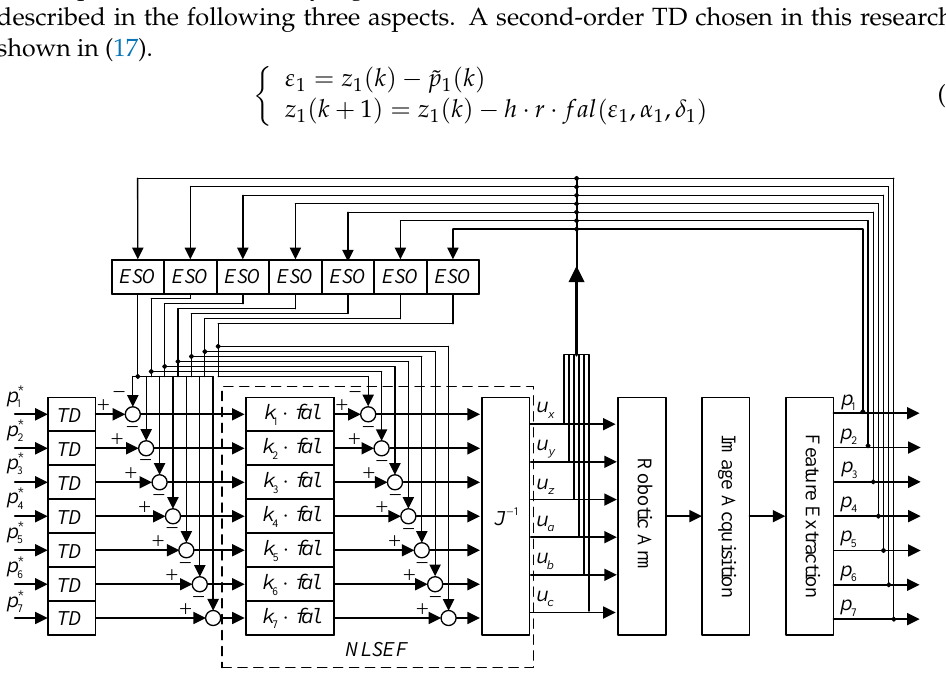
Figure 5. Control system block